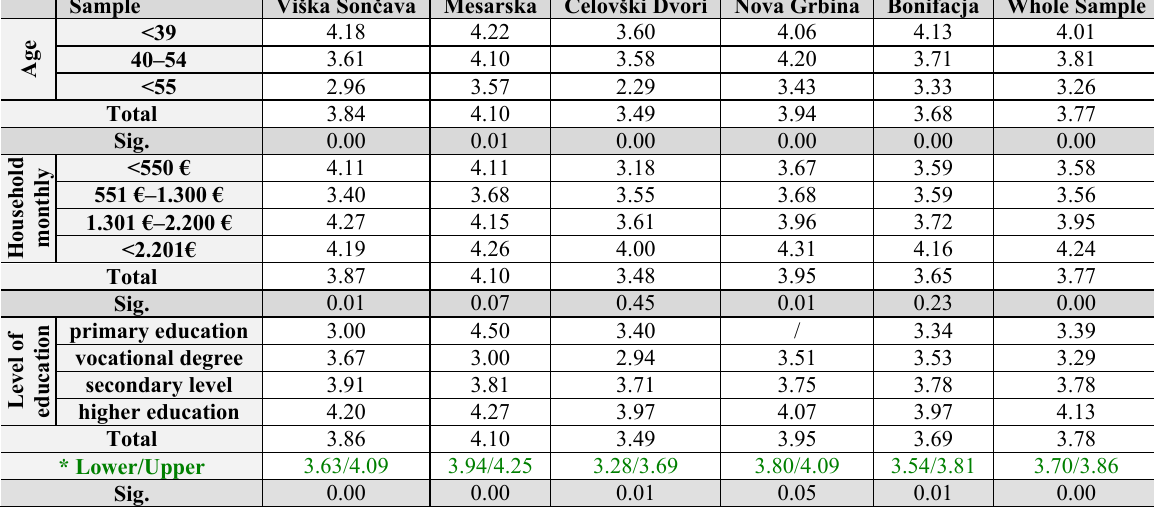
Table 9. Self-evaluation of health according to variables of age, level of completed education and total household monthly income ( * 95% Confidence Interval of the Difference). Sample Viška Son č ava Mesarska Celovški Dvori Nova Grbina Bonifacja Whole